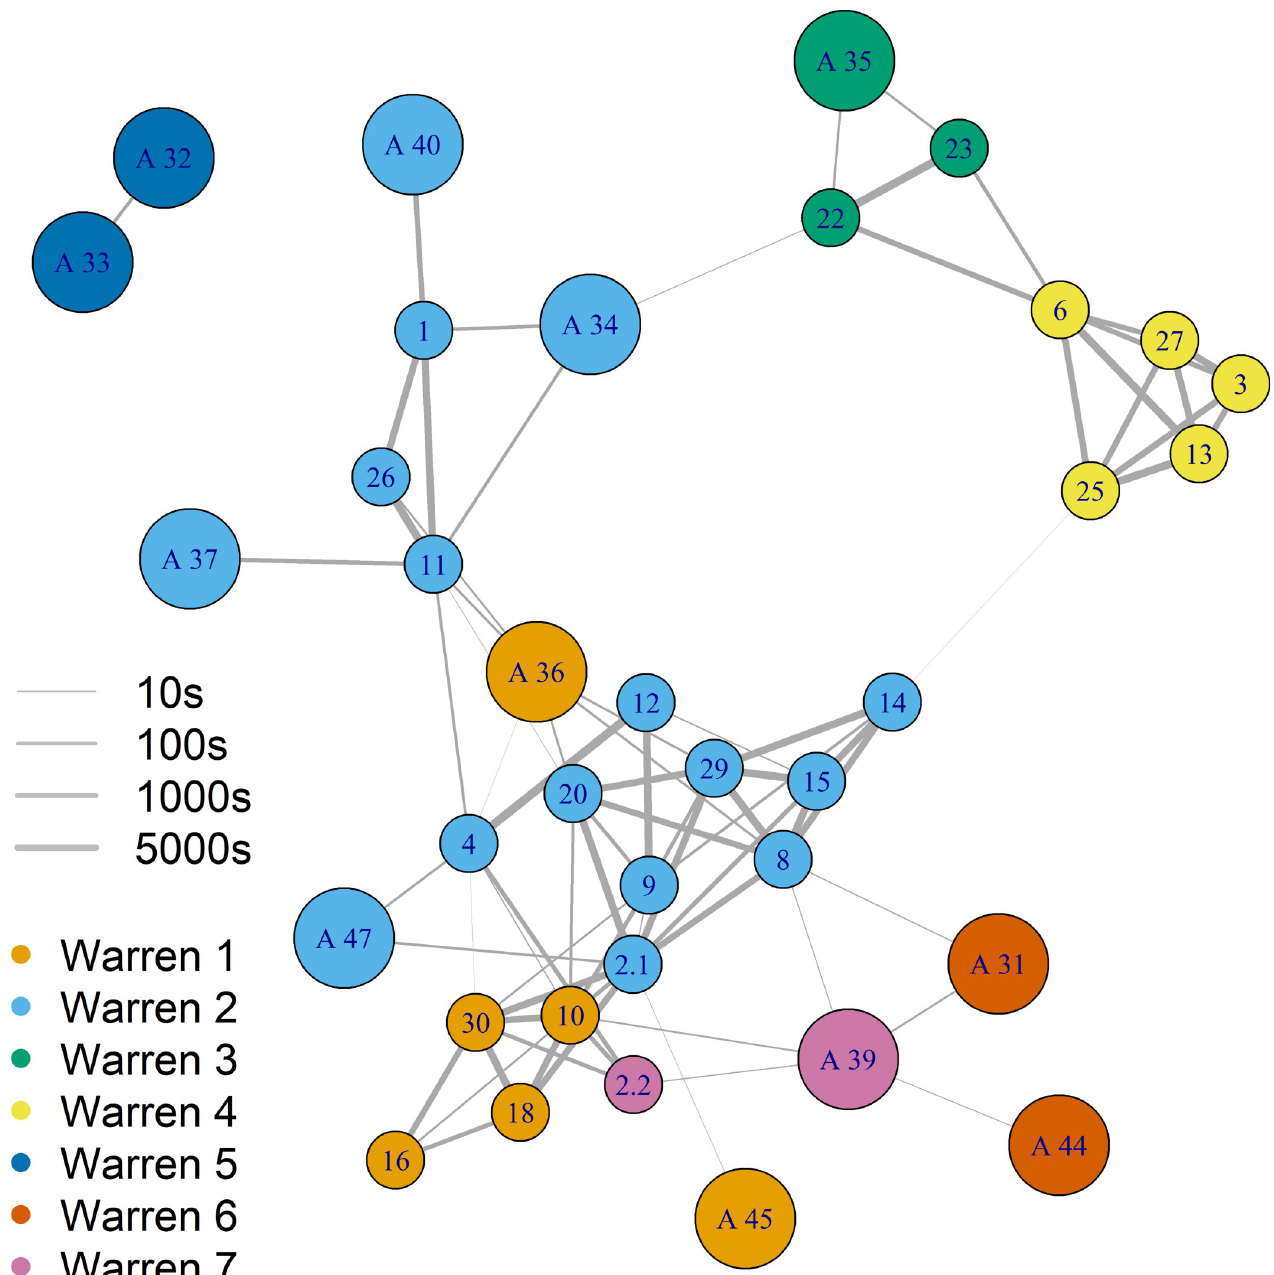
Fig 4. Study time-line showing logger activity (timing and duration of loggers that paired during the study (vertical axis)), between deployment (green points) and retrieval dates (blue points) of juvenile (red) and adult (black) loggers (n = 34 unique loggers with valid pairing data). https://doi.org/10.1371/journal.pone.0271272.g004 (adult logger number 32: 1300 g) tested negative to virus, and the cause of death could also not be determined. We suspected that three other rabbits were taken by predators: one juvenile logger (logger number 21) was found near a red fox ( Vulpes vulpes ) den under a blackberry ( Rubus fruticosus ) shrub and two adult collars (logger numbers 39 and 45) were found with fox bite marks and evidence of chewing. Two other rabbits (logger number 38 and 46) went